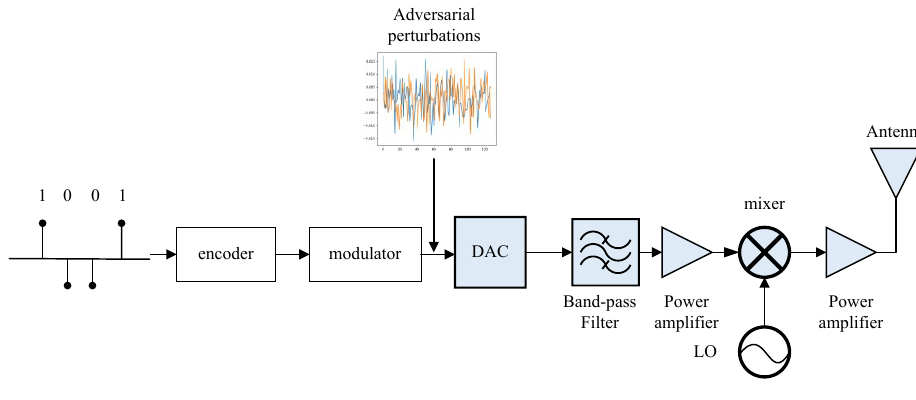
Figure 5. Scheme of the addition of subtle adversarial perturbation at the